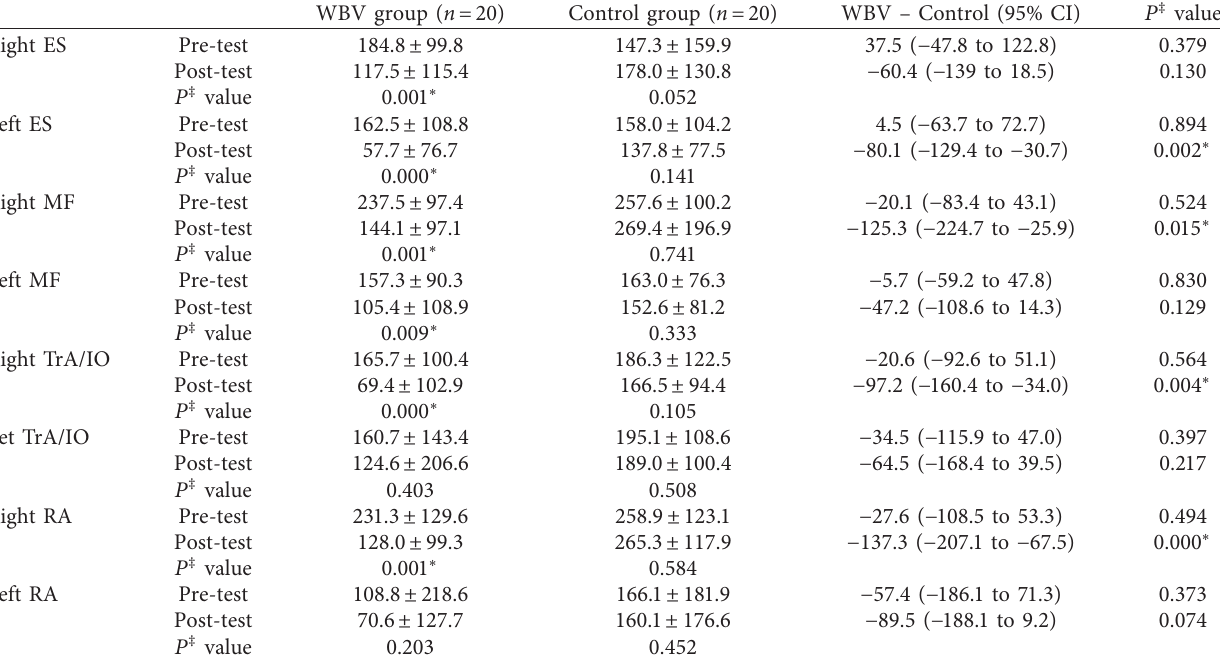
Table 4: Comparison of relative activation time between/within groups on shoulder abduction ( x ± s , unit: